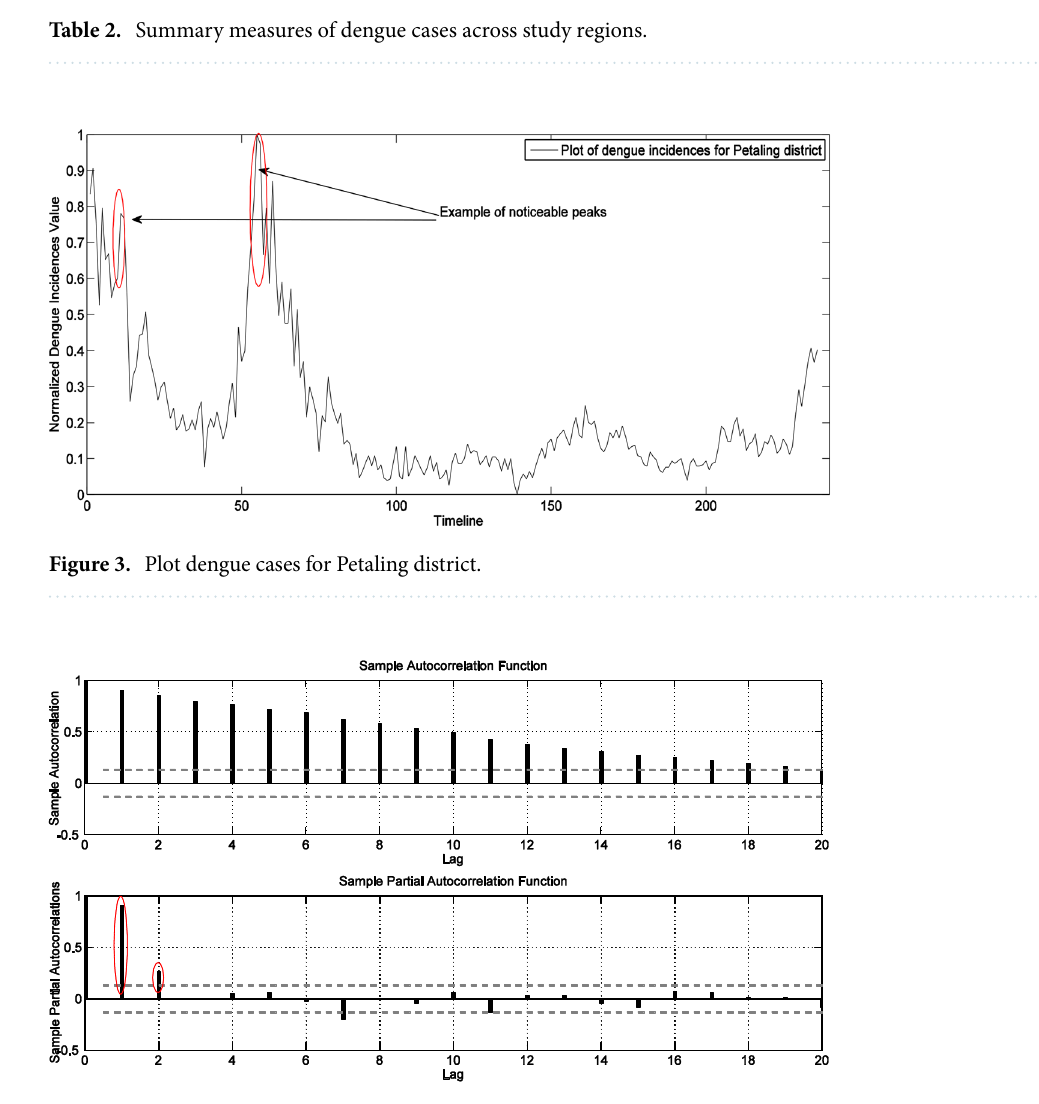
Figure 4. Plot of ACF and PACF for Petaling